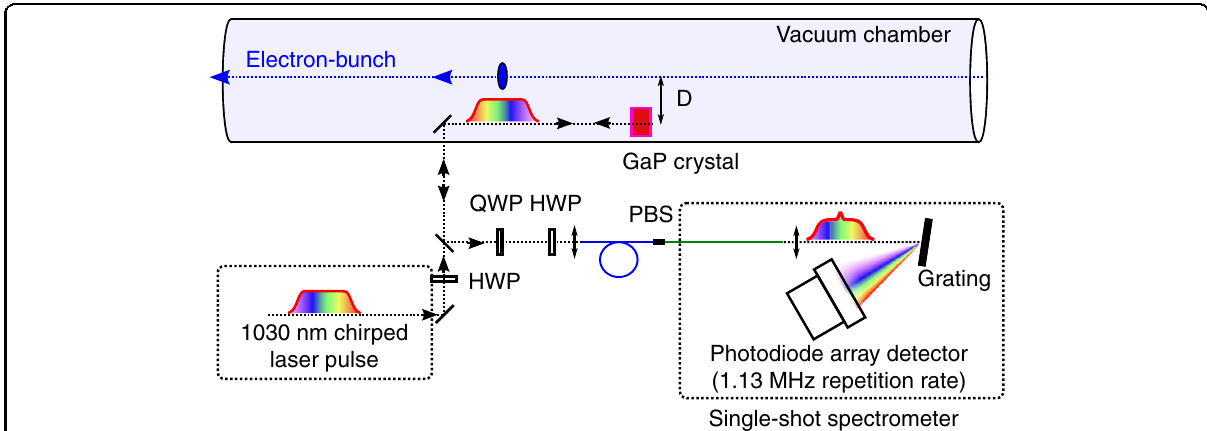
Fig. 6 DEOS measurement of the Coulomb fi eld created by relativistic electron bunches at the European X-ray Free-Electron Laser (Eu- XFEL). A laser beam probes the electric fi eld at a distance D = 5 mm from the electron beam. HWP: half wave plate, QWP, quarter wave plate, PBS, fi ber-based polarizing beam-splitter. Blue lines indicate polarization-maintaining fi bers (PM980) and green lines indicate single-mode fi bers (HI1060). The probe laser is re fl ected on a Gallium Phosphide (GaP) crystal back side. The spectrum readout is performed using a KALYPSO linear array camera operating at 1.13 MHz line rate 51,52 . Details of laser transport and KALYPSO focusing optics are not shown — see ref. 34 for further